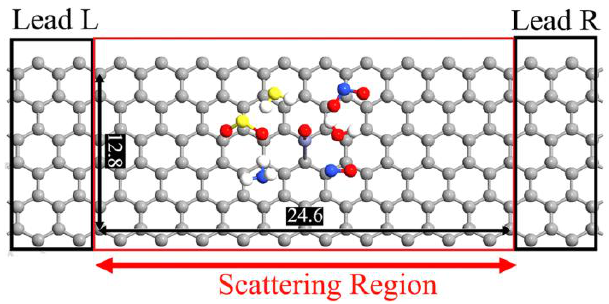
Figure 1. Schematic illustration of zinc oxide (ZnO)–graphene hybrid gas sensor with two leads (black boxes). The gray, purple, red, blue, yellow, and white balls represent C, Zn, O, N, S, and H atoms, respectively. The length and the width of the scattering region (red box) of the sensor (in unit of Å) are also provided.